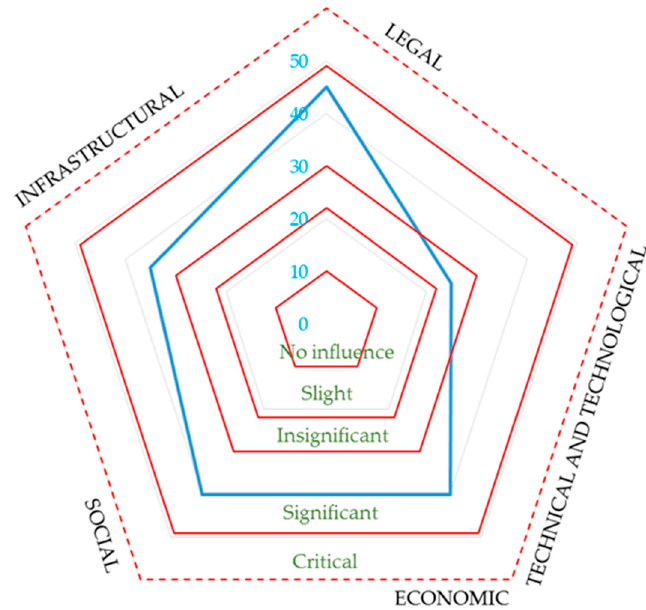
Figure 8. Plot of the effects of regulation effects.